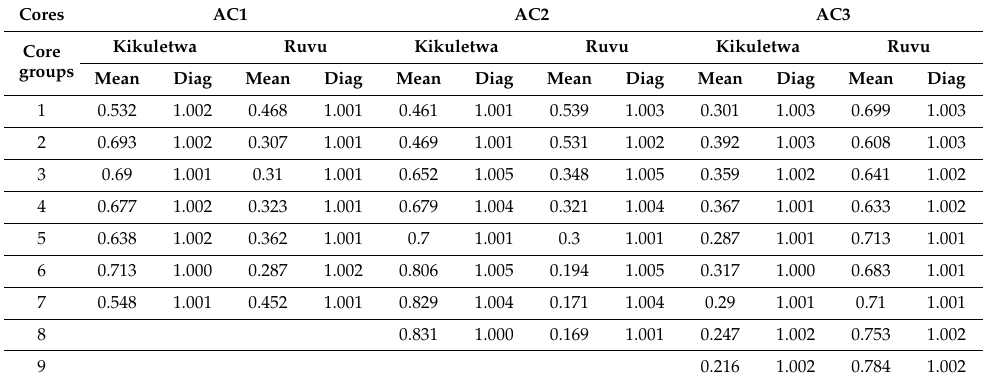
Table A4. The mean values and Gelman diagnostics (Diag.) of the Bayesian Mixing model output of core AC1, AC2 and AC3 specified for grouped core sections.